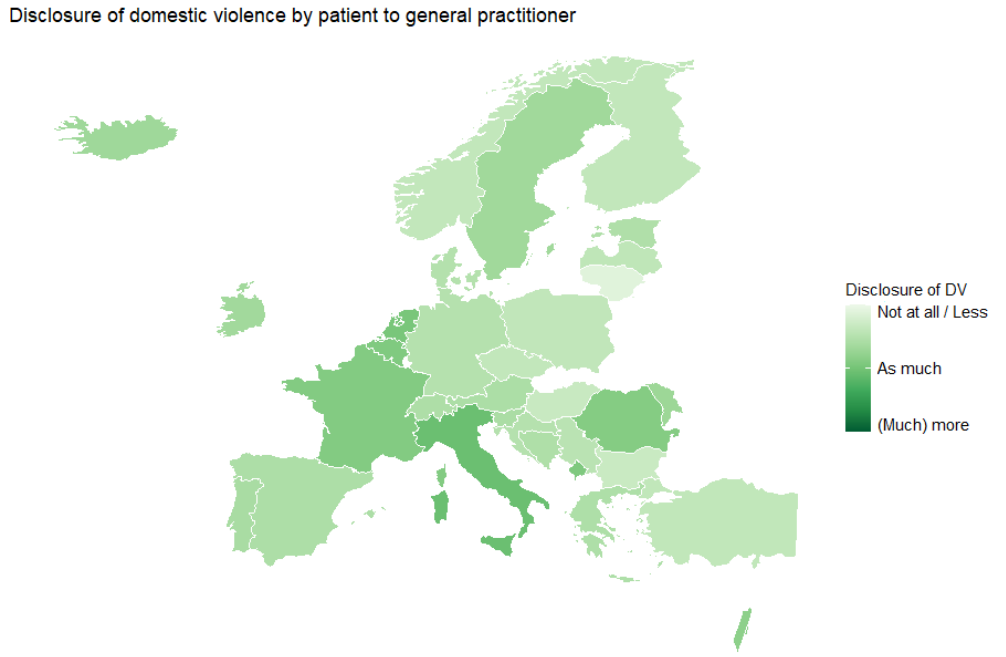
Figure 1. Disclosure of DV by the patient to the GP or GP trainee compared to before the COVID-19 pandemic, average score by country.